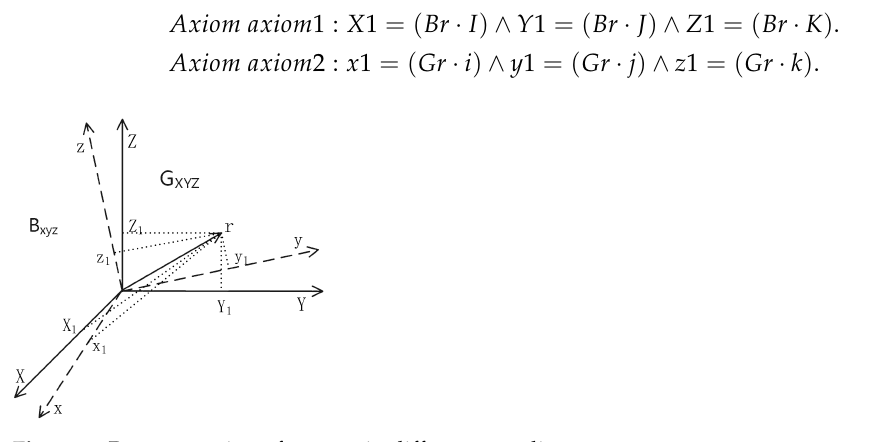
Figure 2. Representation of vectors in different coordinate